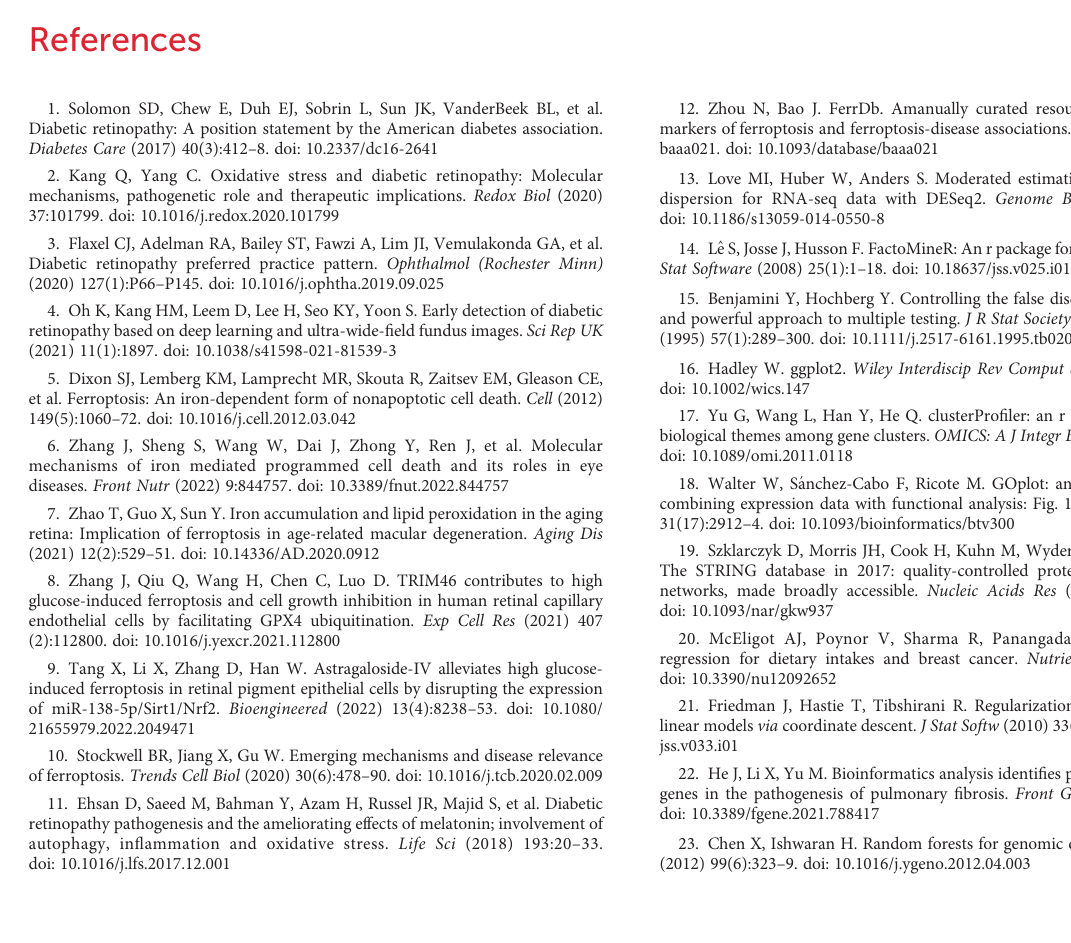
SUPPLEMENTARY FIGURE 1 Principal component analysis. DR, diabetic